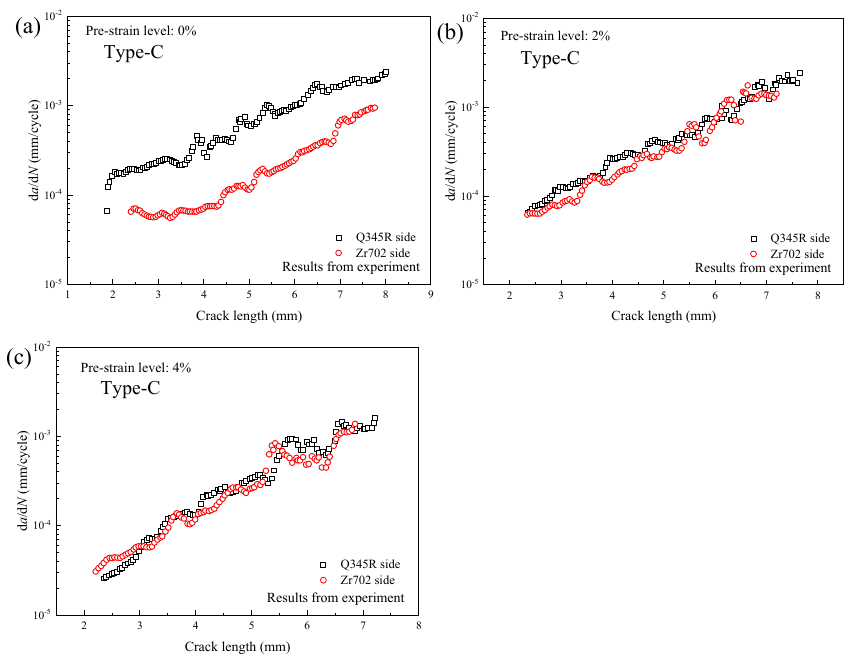
Figure 7. Test results of the through-wall crack with different pre-strain levels: ( a ) 0%, ( b ) 2%, ( c ) 4%.